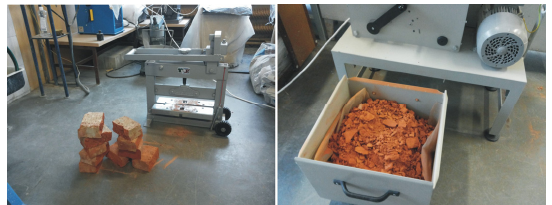
Figure 1. Processing the used bricks by laboratory techniques.